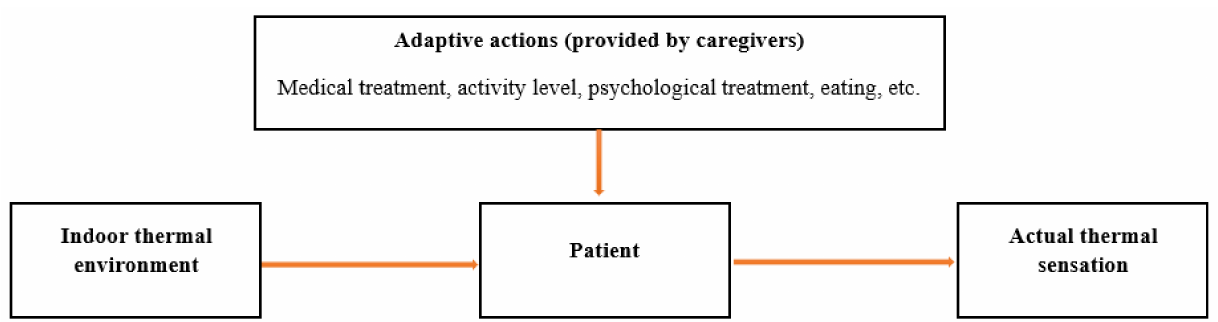
Figure 11. Flowchart of the holistic principle underlying the adaptive